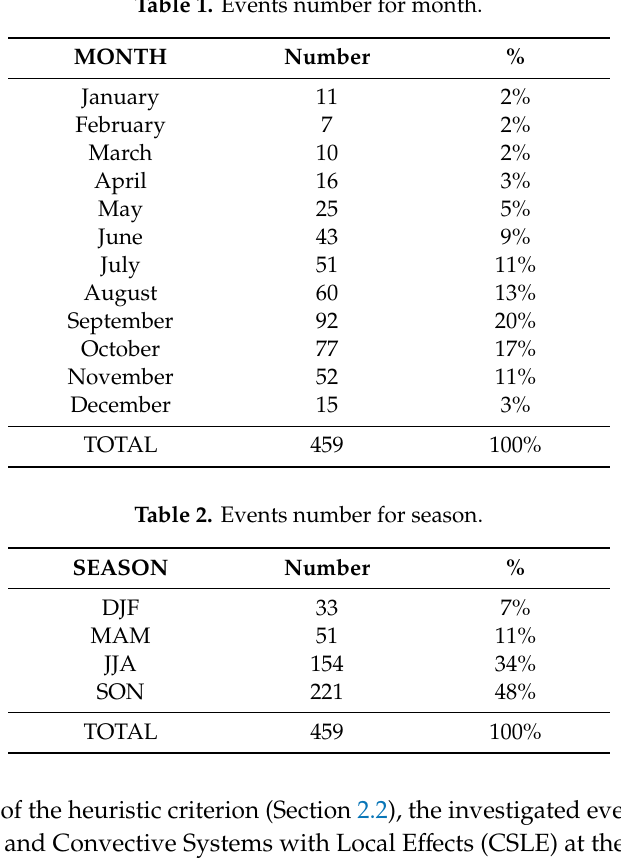
Table 1. Events number for month.